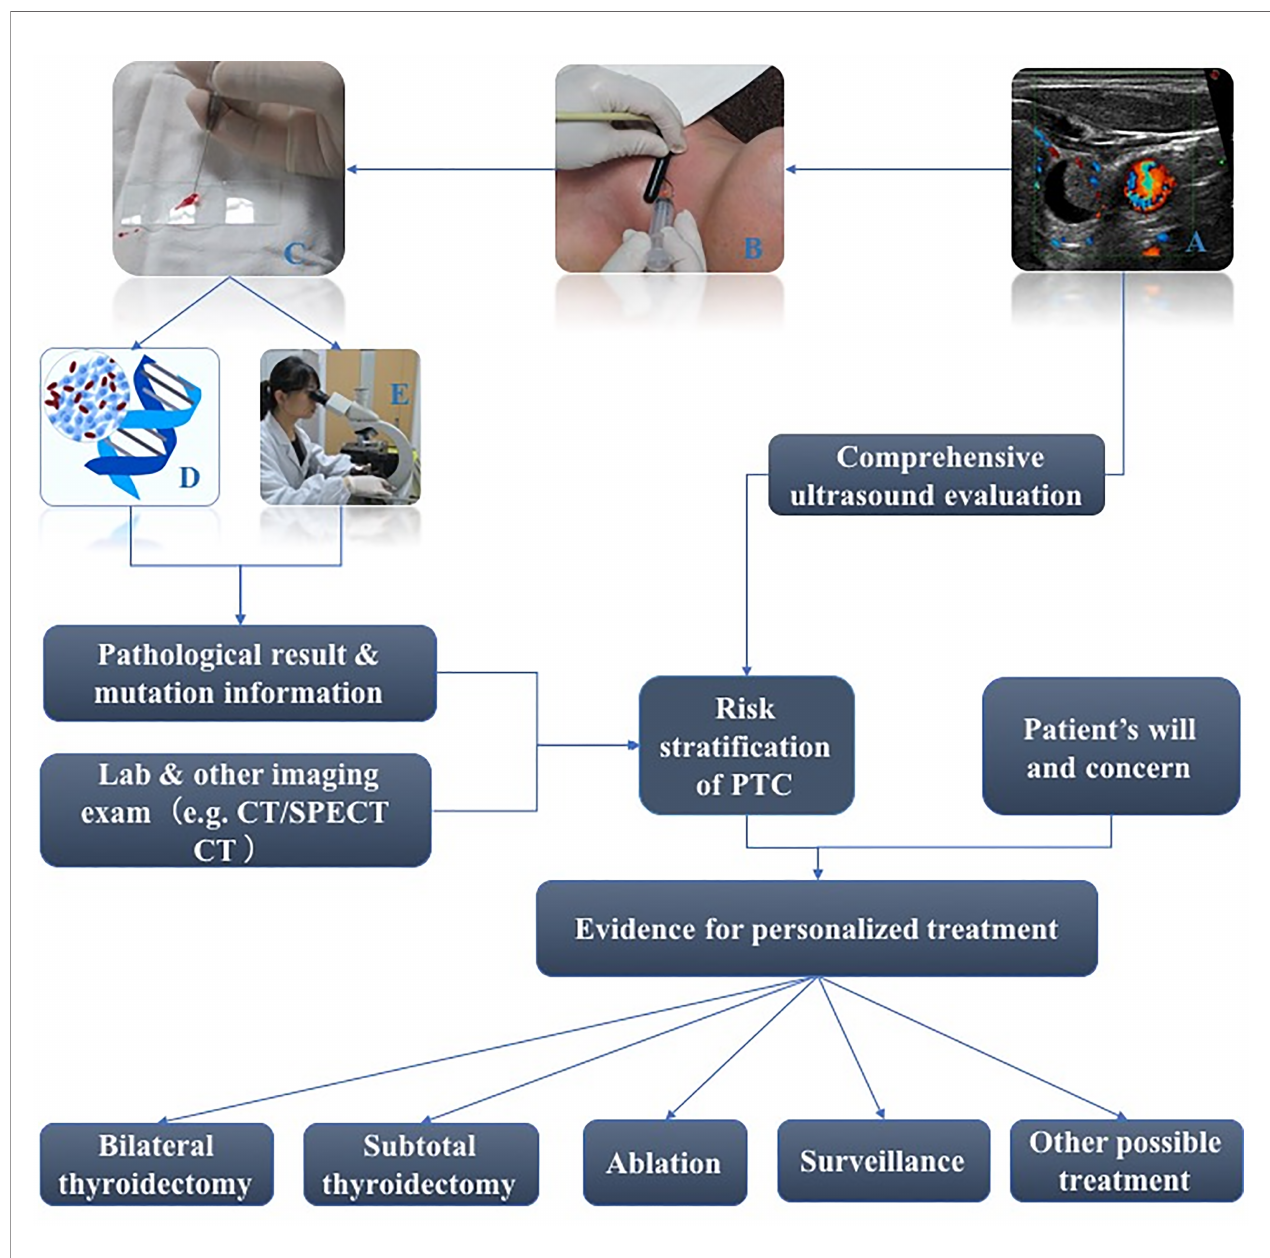
FIGURE 1 | Work fl ow of FNA of thyroid nodule and how gene test participates in management of thyroid nodule ( A : Sonography of a thyroid nodule ready for FNA; B : Real scene of performance of FNA; C : Preoperative FNA Smears; D : A fi gure of gene test; E : Traditional morphology diagnosis based on FNA